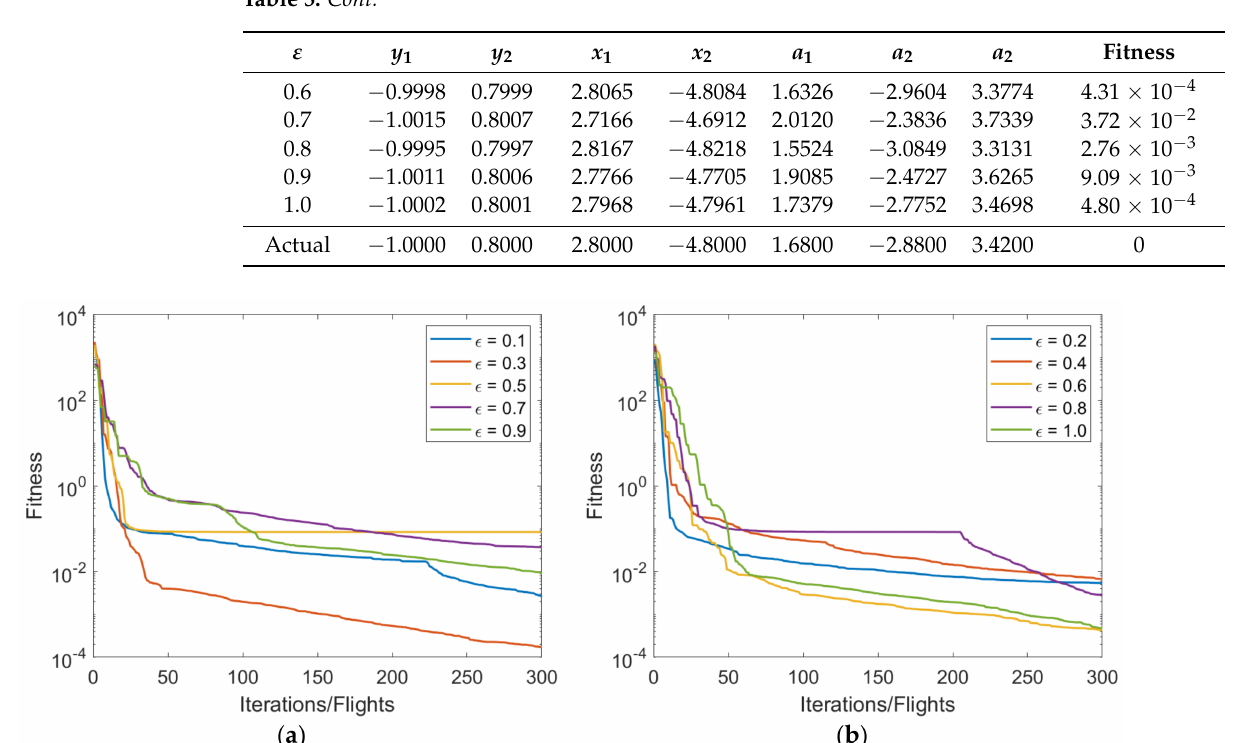
Figure 7. Plots of convergence curves for different fractional orders ε and SNR = 90. ( a ) odd ε and ( b ) even ε .